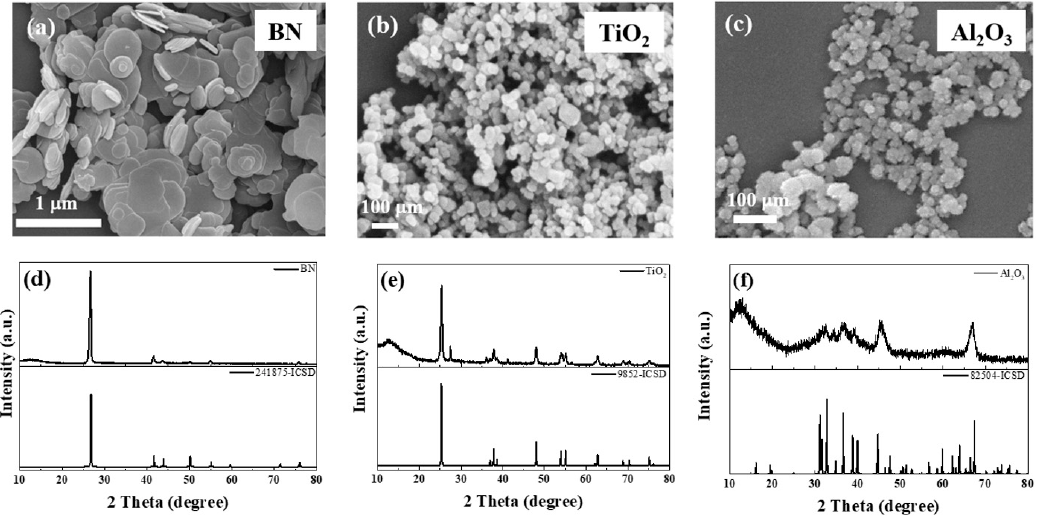
Figure 6. SEM images of ( a ) boron nitride (BN), ( b ) titanium dioxide (TiO 2 ), and ( c) alumina (Al 2 O 3 ); XRD patterns of ( d ) BN, ( e ) TiO 2 , and ( f ) Al 2 O